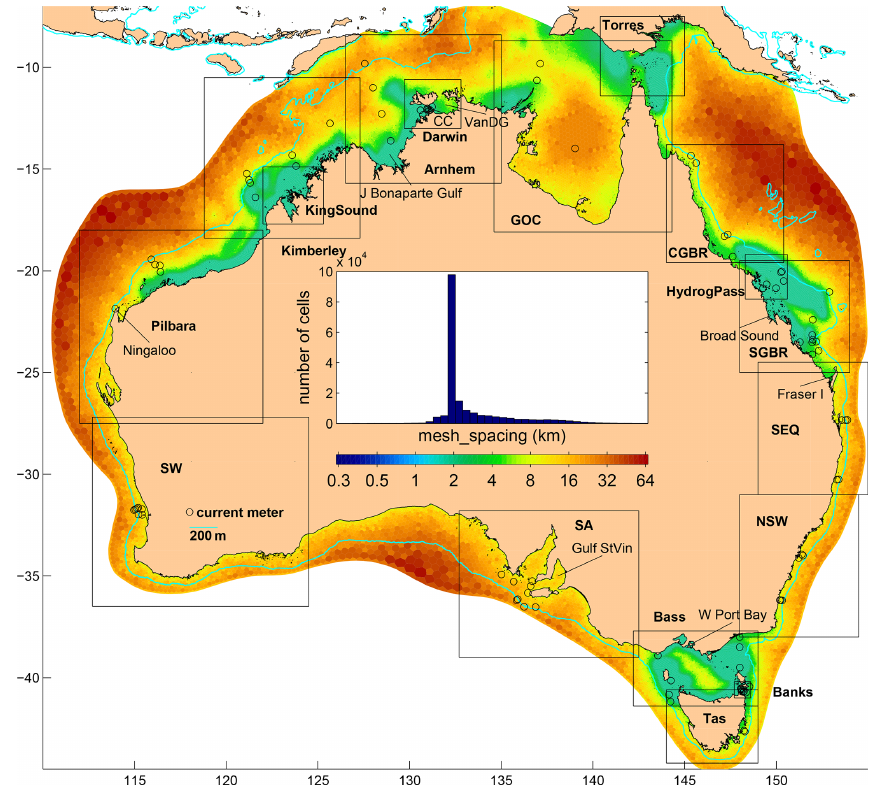
Figure 1. Model mesh spacing (km, log scale). Abbreviated names are as follows. CC: Clarence Channel, VanDG: Van Diemen Gulf, GOC: Gulf of Carpentaria, CGBR: central Great Barrier Reef, SGBR: southern GBR, SEQ: southeastern Queensland, NSW: New South Wales, Bass: Bass Strait, Tas: Tasmania, Banks: Banks Strait, SA: South Australia, SW: the South West. The colour bar tick labels also apply to the bar graph